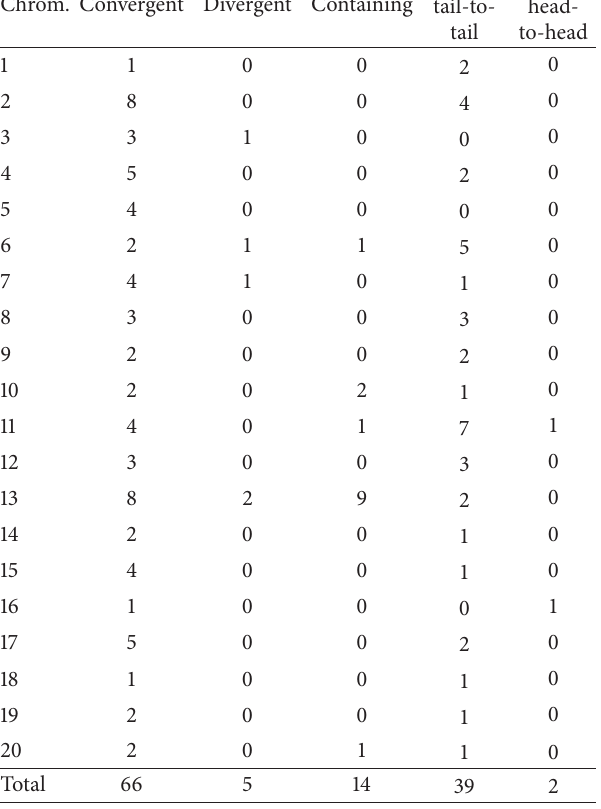
Table 2: Number of soybean genes (loci by chromosome) with unitags SuperSAGE mapped in both sequences of the cis- NAT pairs of five classes.